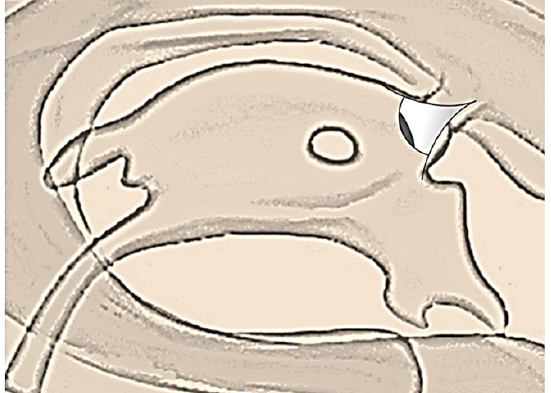
Fig. 16. Direction of the endoscopic viewing angle for the middle segment of the third ventricle.